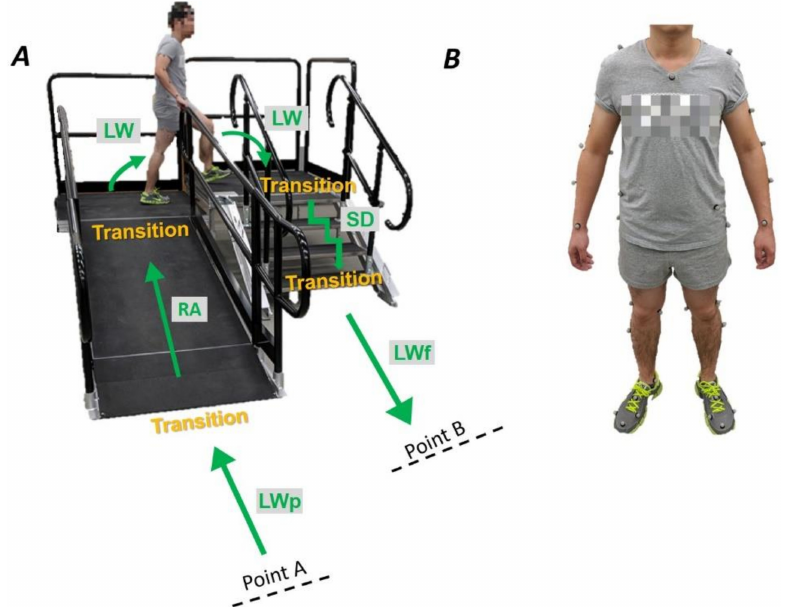
Figure 1. ( A ) “Terrain park” circuit setup was comprised of a four-step staircase, a ramp and elevated platforms. Subjects performed trials of the circuit in the following orders: They started at point A, performed the locomotion as shown, and stopped at point B. They executed the tasks in the reverse order in the next trial, starting at point B and ending at point A. Circuit trials were performed for both the left leading and right leading legs. ( B ) Sixty-six reflective markers were attached to anatomical body locations to track 12 body segments of the arms, legs, and